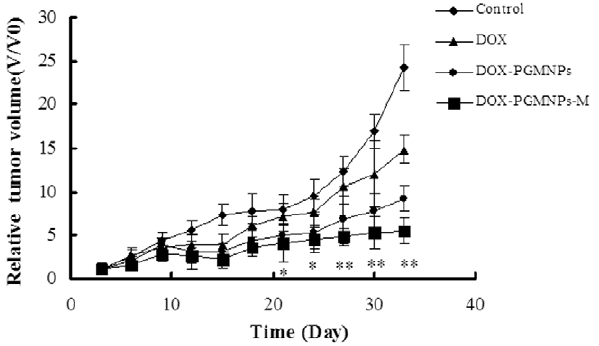
Figure 5. Tumor growth curves of H22 tumor –bearing mice model that received different treatments indicated. Effective inhibition of the tumor growth can be seen resulting from the DOX- PGMNPs and DOX-PGMNPs-M treatment strategies. The same doxoru- bicin dose was injected to H22 tumor –bearing mice model for DOX, DOX-PGMNPs and DOX-PGMNPs-M. The same volume physiologic saline solution injected to H22 tumor –bearing mice model as control. * p , 0.05; ** p , 0.01 compared with controls using Student’s unpaired t- test.